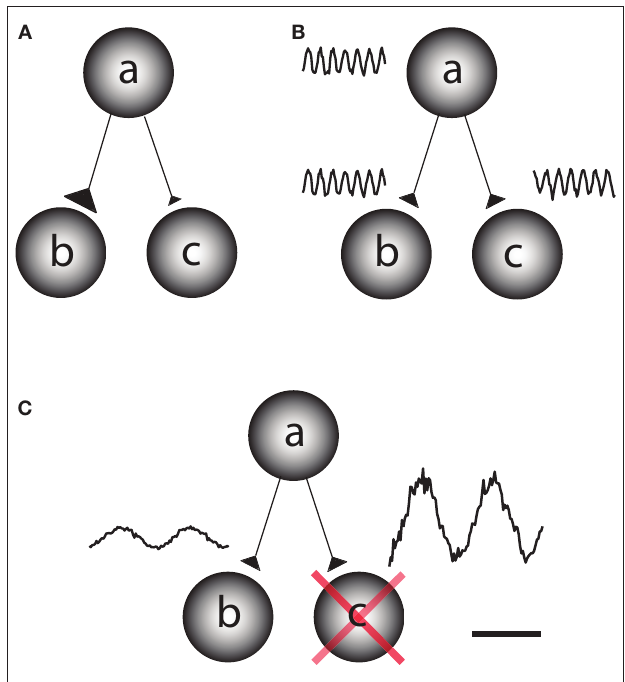
Figure 1 | Different principles by which information can be gated through a network. Consider a situation in which information is supposed to be routed from node a to node b but not from node a to node c . (A) One possibility is that the synaptic connections from node a to b are strengthened on a fast time scale and weakened from node a to c . This would require a mechanism for synaptic plasticity that works on a fast time scale. (B) Information might be gated through neuronal phase-synchronization between node a and c . The information flow from node b to c is blocked by adjusting the phase difference. (C) We here promote the principle of gating by inhibition. Node c is actively suppressed by functional inhibition. This serves to gate the information flow from a to b . The functional inhibition is reflected in the 9–13 Hz alpha